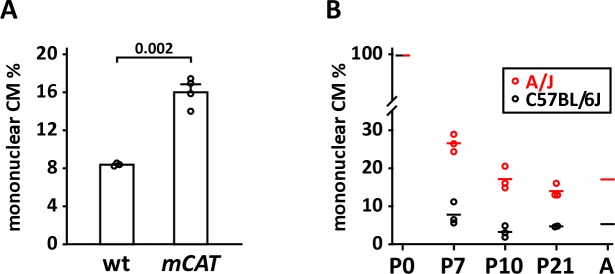
Mononuclear cardiomyocyte content.(A) Comparison of mononuclear cardiomyocyte level in wild-type control and mCAT transgenic C57BL/6J-inbred littermate pups at P7. (B) Comparison of mononuclear cardiomyocyte percentage in uninjured strains A/J (red) and C57BL/6J (black) at P7, P10, and P21. Average values for P0 and adult (8 weeks) for both strains were taken from Patterson et al. (2017) and were not newly measured in this study.